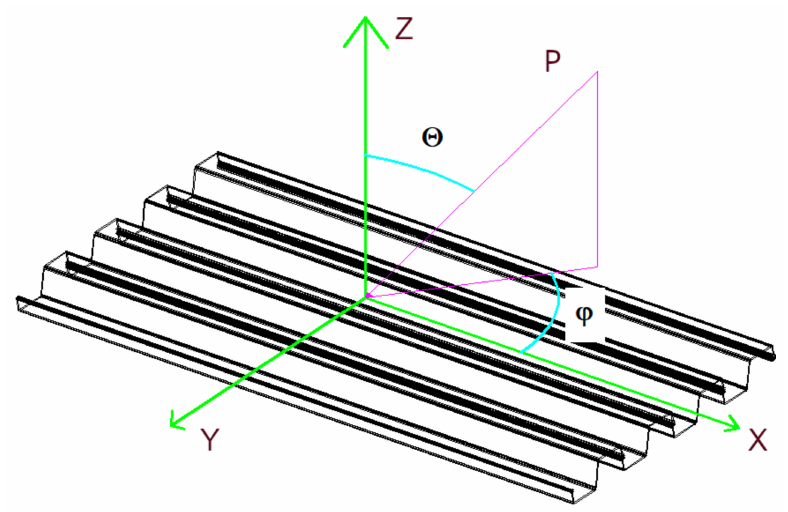
Figure 1. Panel coordinate system indicates incident